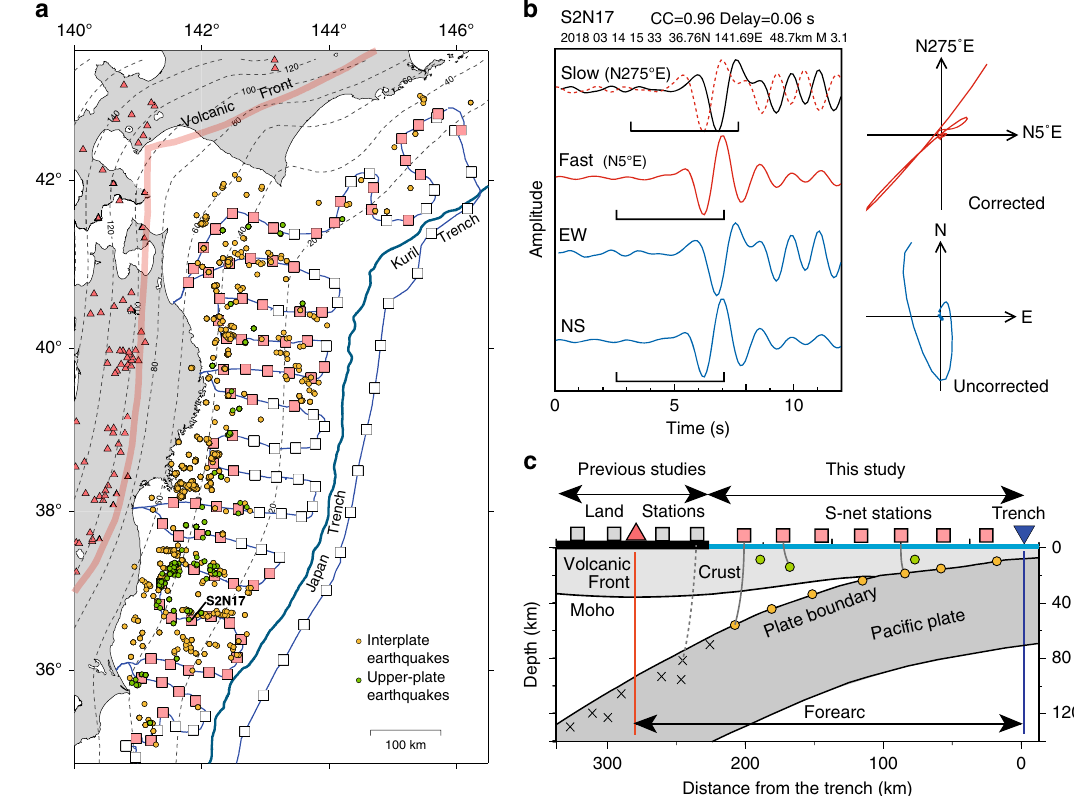
Fig. 1 The S-net sea fl oor seismometers and the principle of shear-wave splitting analysis. ( a ) Distribution of the S-net stations (squares) and the earthquakes used in this study. Orange and green circles show the interplate earthquakes and upper-plate earthquakes (depth ≤ 35 km), respectively. Red squares are the stations that have one or more splitting parameter estimations. Red triangles are the Quaternary volcanoes and thick pink lines show the volcanic front. Dashed contours show the depth to the subduction interface with an interval of 10 km. ( b ) Example of the procedure of the splitting parameter estimations. Left panel shows S waves. Bottom two traces show the original EW and NS components, and the top two traces show rotated waveforms to fast and slow directions. The dashed line in the slow direction is the waveform shifted with the amount of delay time. On the top, the station name, cross-correlation coef fi cient, delay time, and the earthquake source information are shown. The station location is also shown in ( a ). The right panel shows the particle motion for the original (uncorrected), and rotated and delay-time-corrected (corrected) waveforms. Note that the split shear-waves have similar waveforms in the fast- and slow- directions, and the cross-correlation value between the waveforms in the fast and slow directions becomes maximum for the direction and time shift. ( c ) Schematic cross-section view of the structure around 39°N [modi fi ed from Uchida et al., 2010 50 ]. The source earthquakes are located on the subduction interface and the S-net stations are located above them. The S-net covers a large area in the forearc. Orange and green circles represent the offshore interplate and upper-plate earthquakes used in this study while crosses represent intraslab earthquakes used in previous